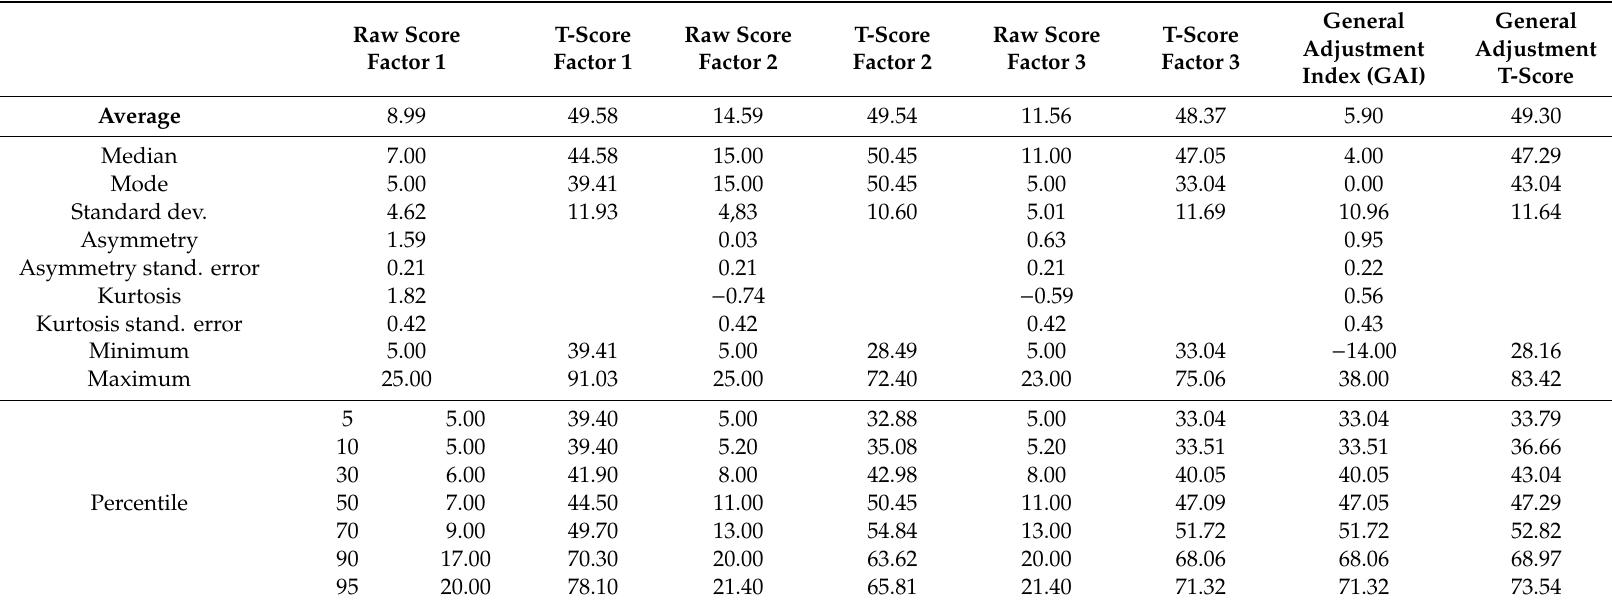
Table 6. CAFIAR’s statistical data, 15-item